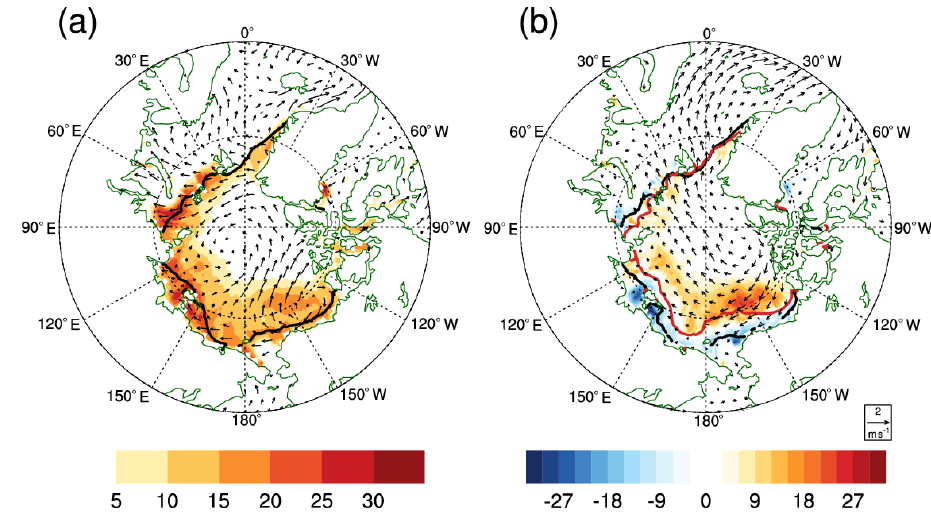
Figure 2. (a) Climatological-mean (1982–2017) pattern of surface wind at 10m during JJA (vector, ms − 1 ) and the SIE in September (solid line). The shaded area shows the standard deviation from the detrended yearly variation of September SIE in each location. (b) The difference of time-mean surface wind (vector, ms − 1 ) and the standard deviation of September SIE between the recent and the early period (1998–2017 minus 1982–1997; shaded). The solid lines indicate the SIE for the early (black) and the recent (red) period,